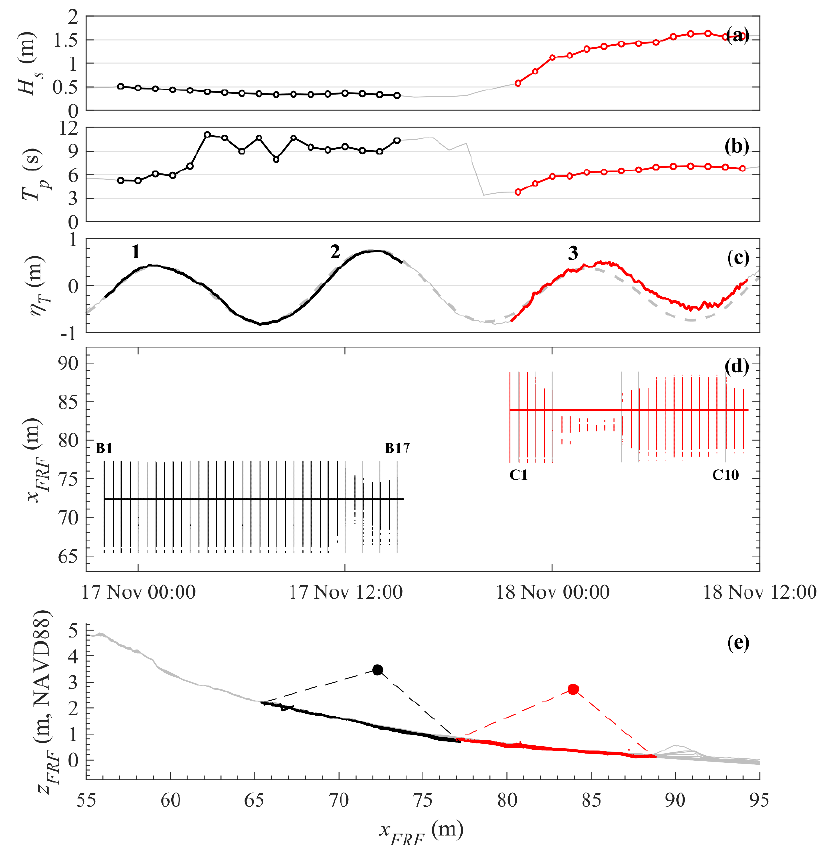
Figure 5. ( a ) Significant wave height, ( b ) peak wave period, and ( c ) measured (solid) and predicted (dashed) tidal water levels (NAVD88) at the USACE FRF in Duck, NC (NOAA Station ID: 8651370). The black (red) overlays indicate measured tidal water levels during the time span for the Series B (Series C) deployment. ( d ) Plan view time stack and ( e ) profile view of the half-hourly, time-averaged cross-shore beach profiles measured by the LLC LiDAR and the corresponding hourly FRF DUNE LiDAR profiles (gray). The FRF DUNE LiDAR cross-shore profile extents are truncated in ( d ) to demonstrate the spans over which statistics were computed in Table 1. Transects numbered in ( d ) correspond to Profile numbers in Table 1. The thick horizontal lines intersecting the profiles in ( d ), and the solid circles in ( e ), mark the locations of the LLC LiDAR puck. Dashed lines in ( e ) represent the field of view of each LLC LiDAR. Black (red) colors correspond to Series B (Series C) in all panels. Times in UTC.